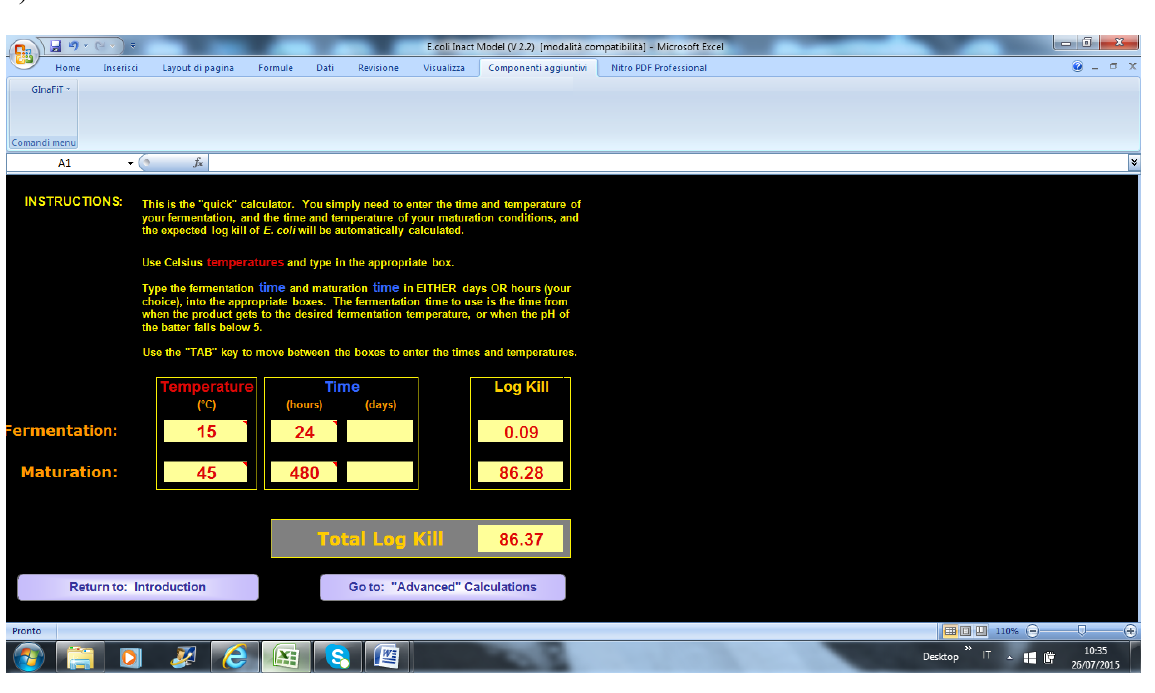
Figure 3. Output in MLA- quick